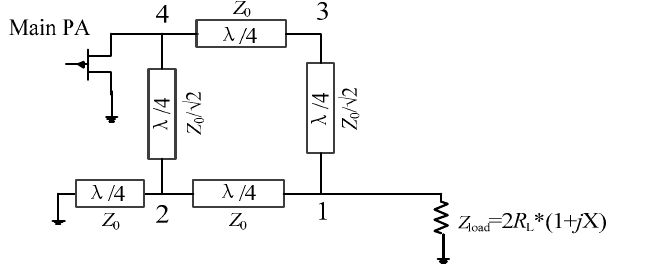
Figure 5. Equivalent schematic diagram of the main PA branch at the saturation level.